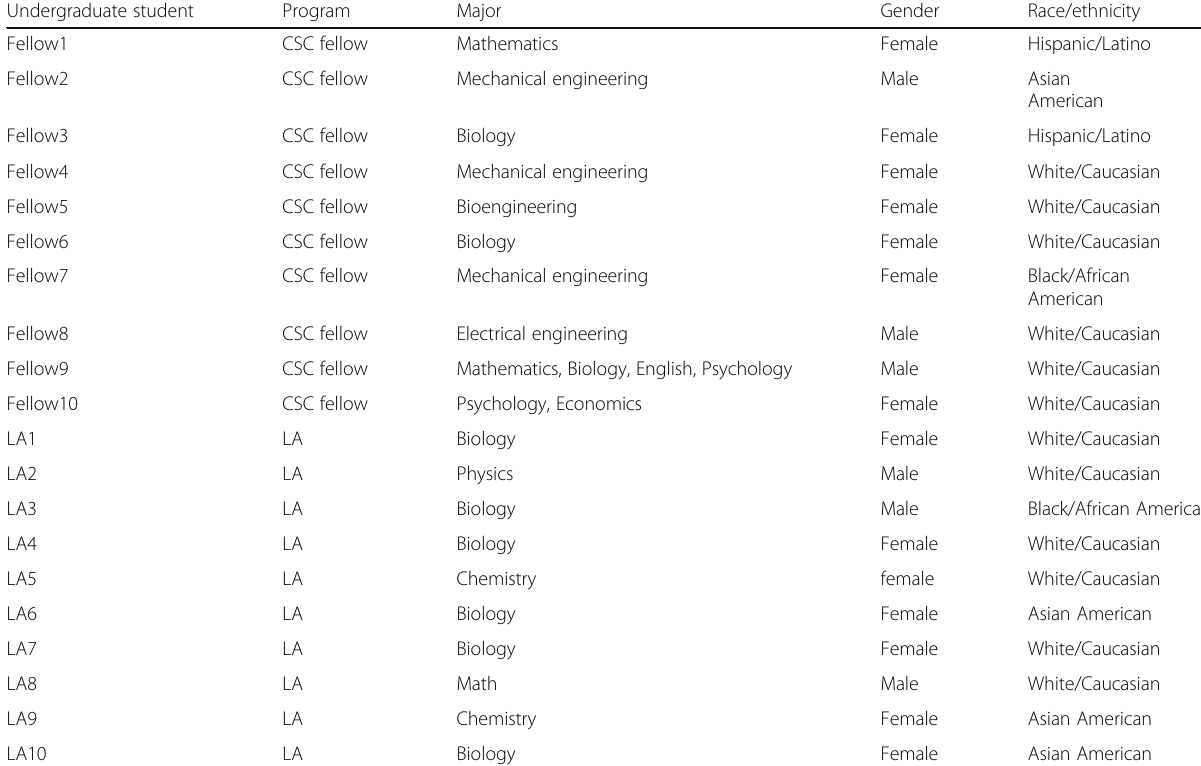
Table 2 Sample of SSOP